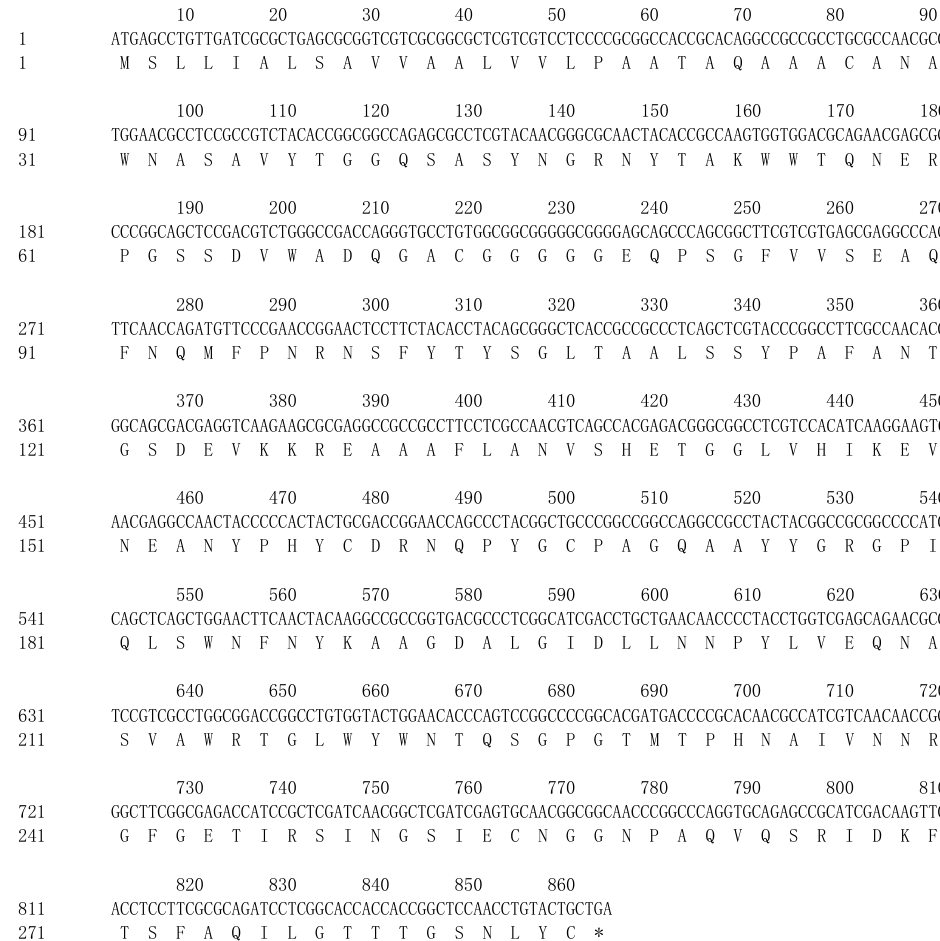
Figure 3. The sequence of ChiKJ406136 gene and its encoded amino acid sequence.